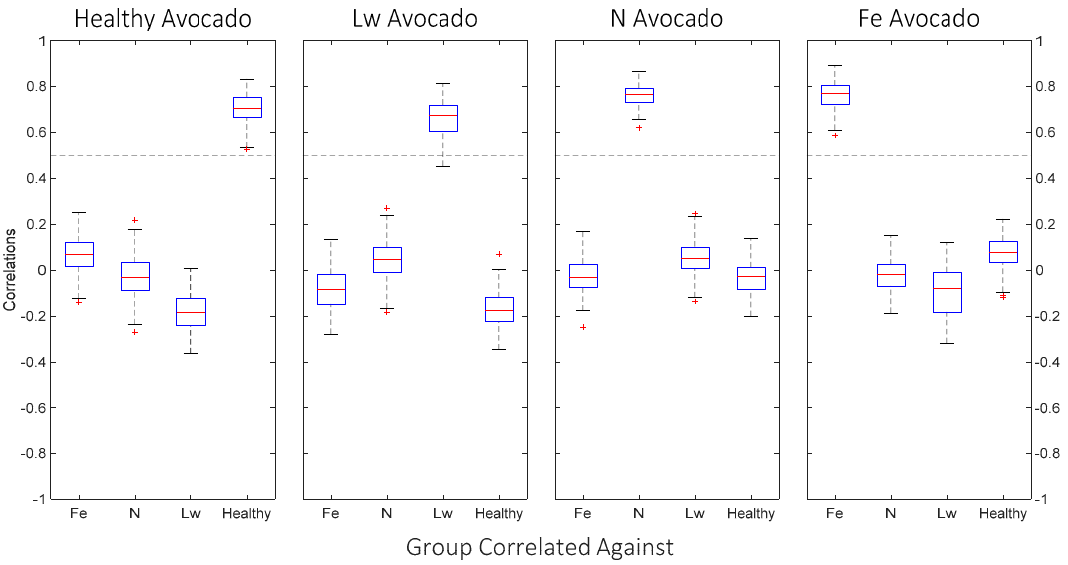
Figure 9. Results of FDA-BC algorithm; Results of Bivariate Correlations of Finite Difference Approximations for all leaf groups using autocorrelation for leaves of the same category, and cross-correlation with other categories.